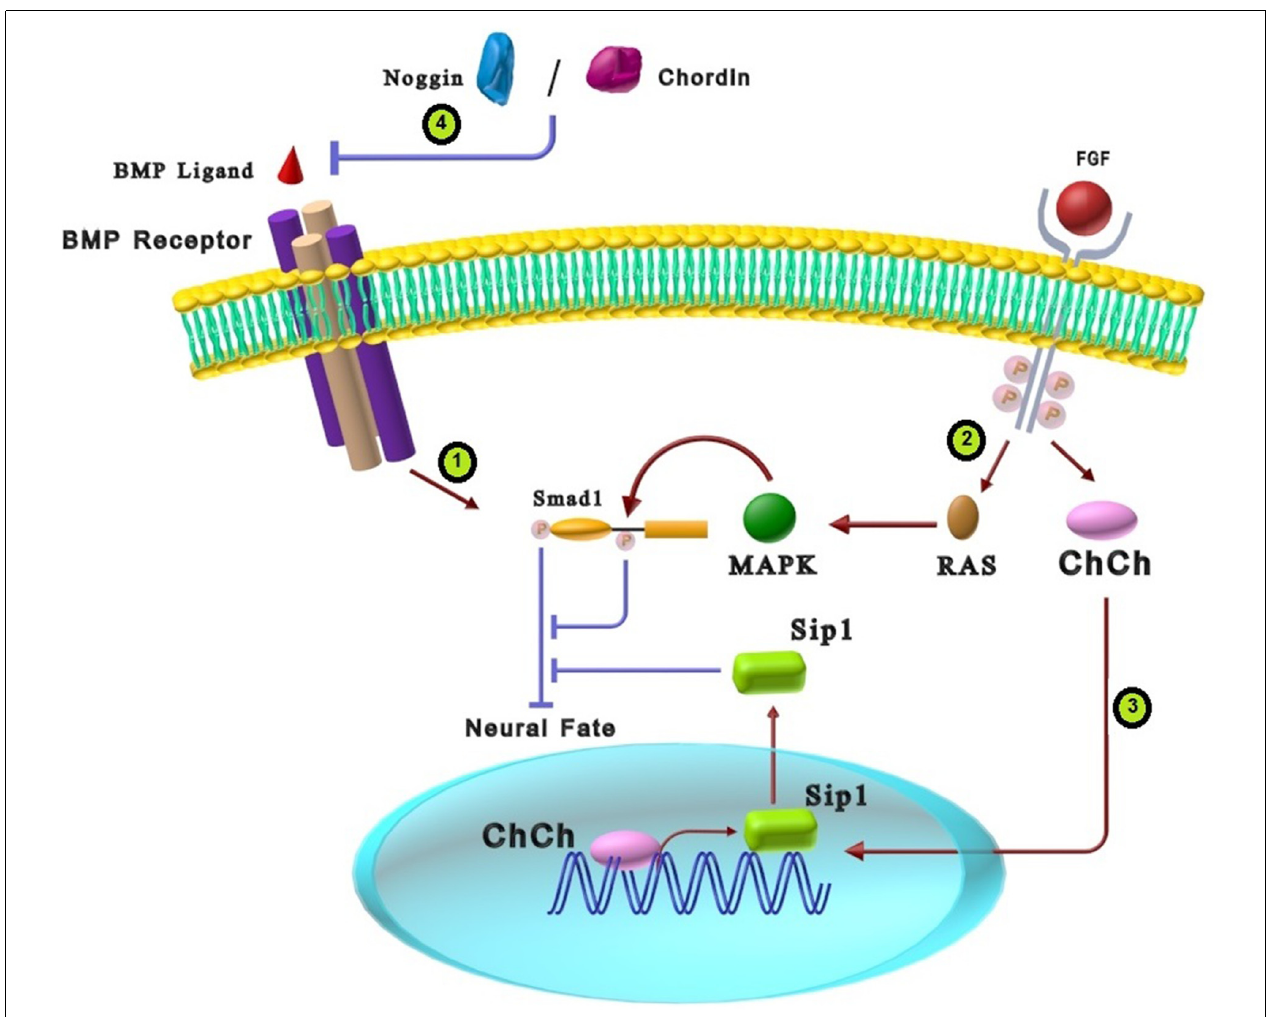
FIGURE 2 | The cross-talk between BMP and FGF signaling pathways in neural differentiation. (1) BMP ligands activate the BMP receptors that result in Smad1 C-terminal phosphorylation and, consequently, Smad1 activation. C-terminal phosphorylated Smad1 inhibits neural fate. (2) Interaction of FGF ligands and tyrosine kinases receptors can activate RAS-MAPK intracellular signaling that causes phosphorylation of Smad1 linker domain. Phosphorylation of Smad1 in the linker region results in inhibition of Smad1. Inactivation of Smad1 due to FGF function induces neural fate in stem cells. (3) FGFs can also stimulate a zinc finger transcriptional activator, Churchill (ChCh), which increases Sip1 expression. Sip1 suppresses BMP signaling that consequently induces neural fate. (4) There is a strong synergy between the effects of BMP antagonists (Chordin and Noggin) and FGF in neural